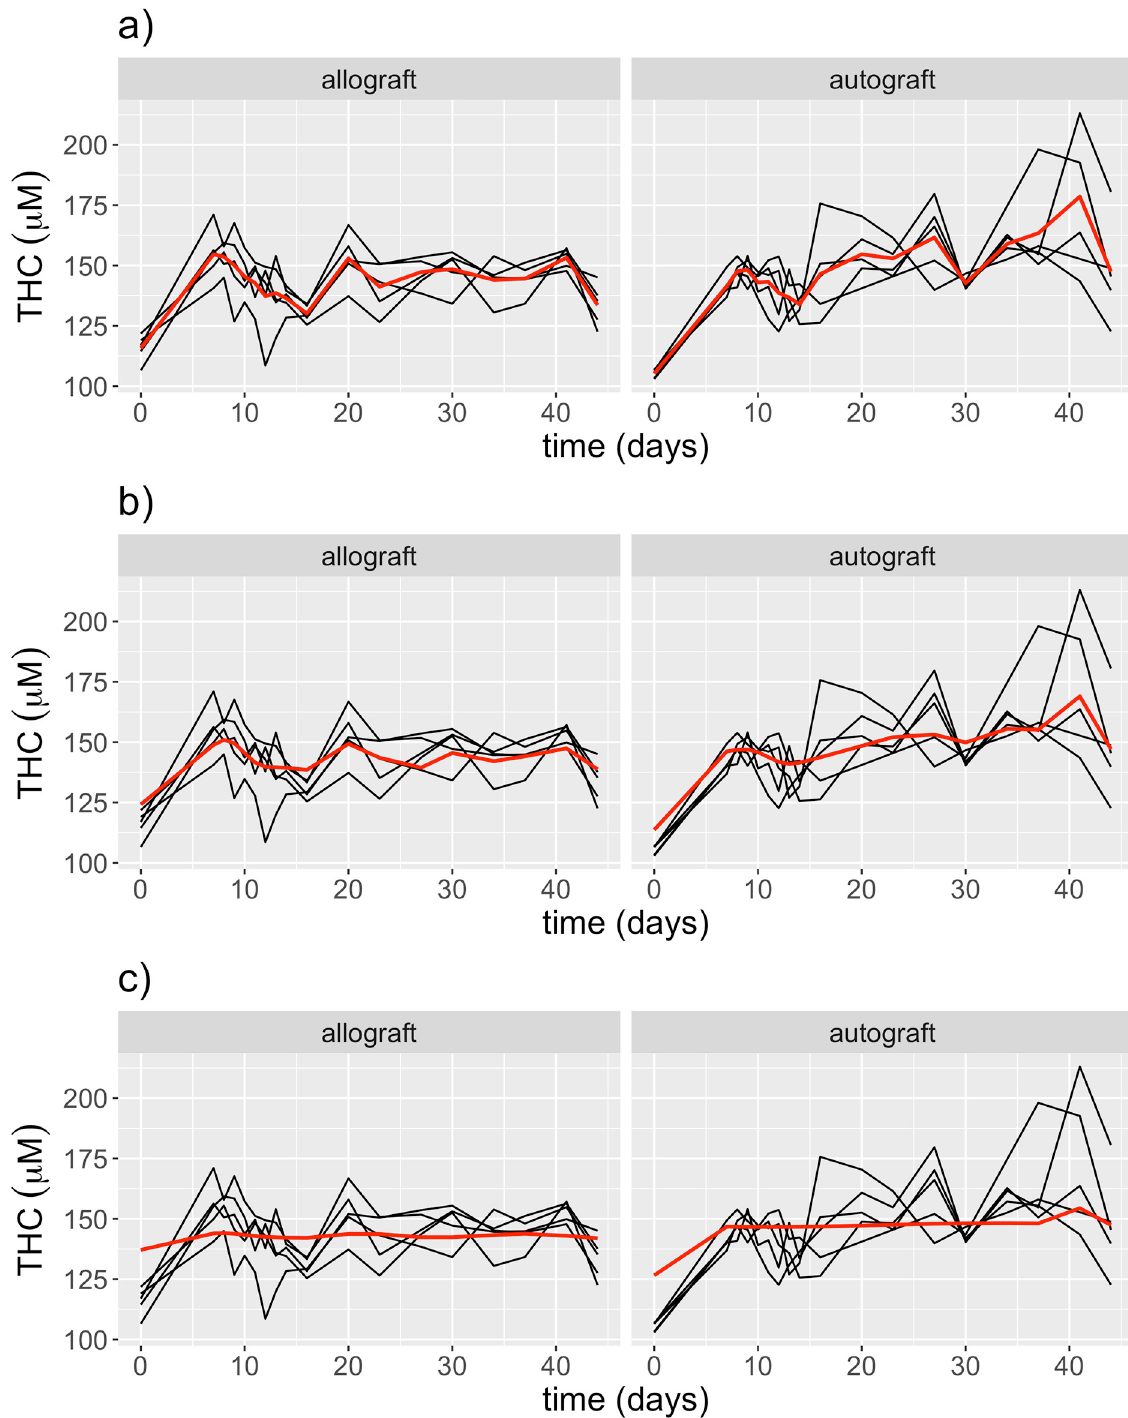
Fig 4. Estimated THC by SMM (red curve) for the allograft group (left) and the autograft group (right) with different values of γ . Black curves are observed THC trajectories. a) SMM estimates using γ = 0, b) SMM estimates using γ = 0.5, c) SMM estimates using γ = 2.